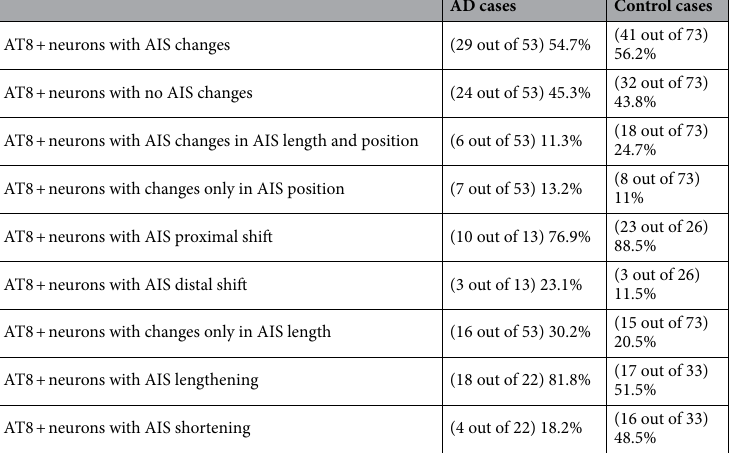
Table 3. Table showing percentage values of AT8-immunopositive neurons with AIS length and/or position changes in compared to AT8-immunonegative neurons in AD and control cases. Note that some AT8- immunopositive neurons may contain more than one type of AIS change at the same